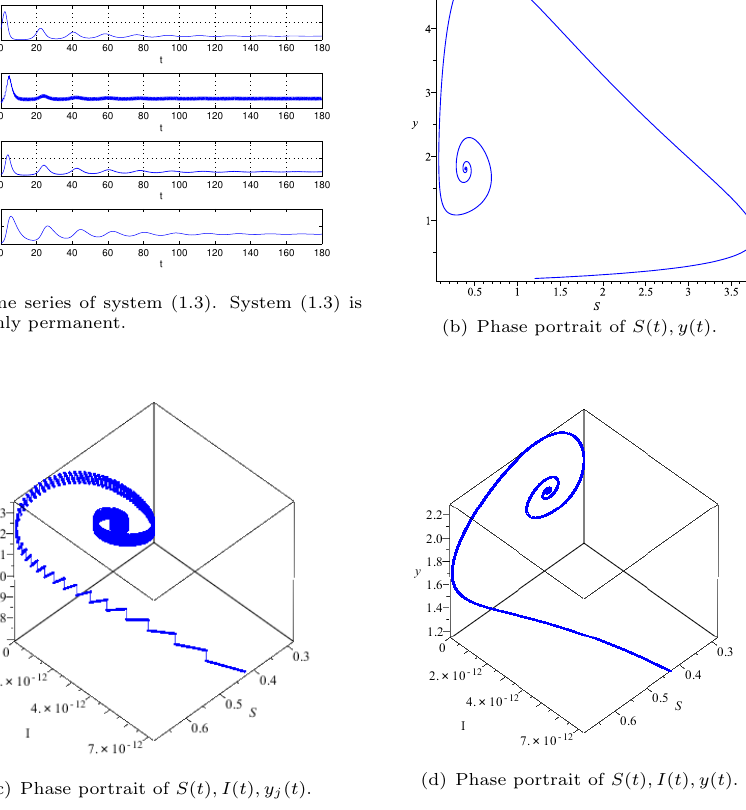
Figure 3. The results of numerical simulation on the threshold values R 2 = 7 . 1749, where l = 0 . 5; p = 0 . 05; q = 0 . 05, T = 0 . 3; τ = 0.